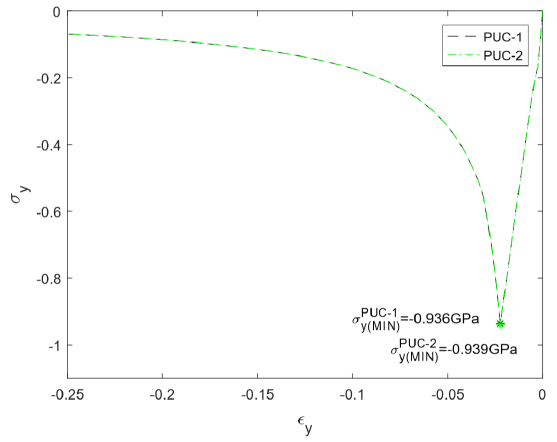
Figure 9. Stress-strain curves for on-axis compressive loading in the